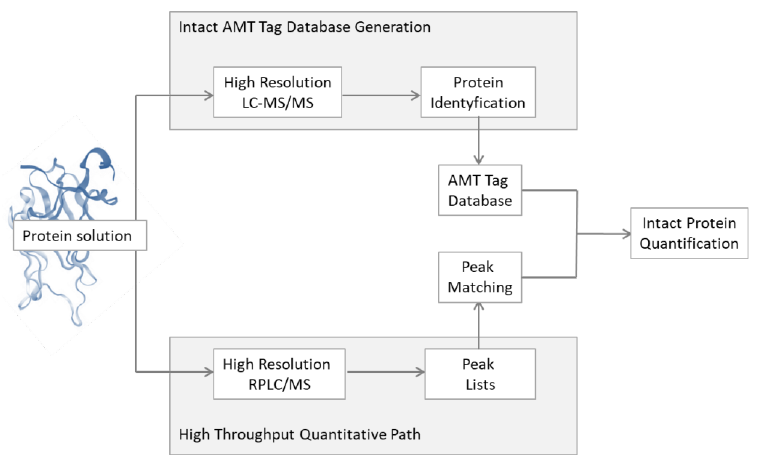
Figure 6. Schematic presentation of the quantification withe use of the accurate mass and time AMT Tag approach. Tag